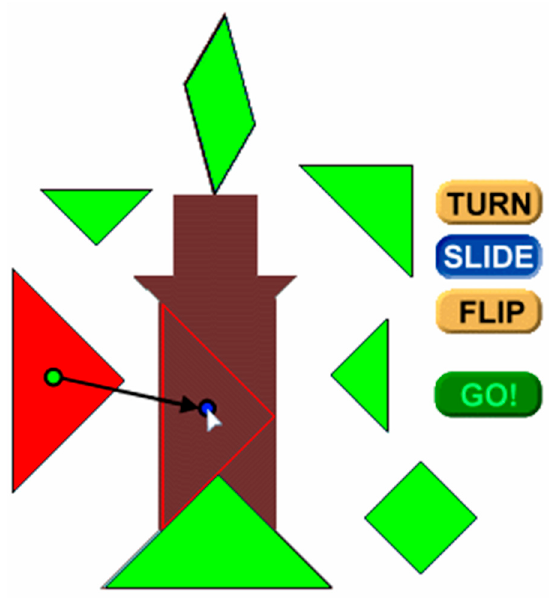
Figure 3. A game based on Chinese Tangram puzzles, in which the player is moving a polygon by acting on an intermediary representation (a representation of the translation vector).